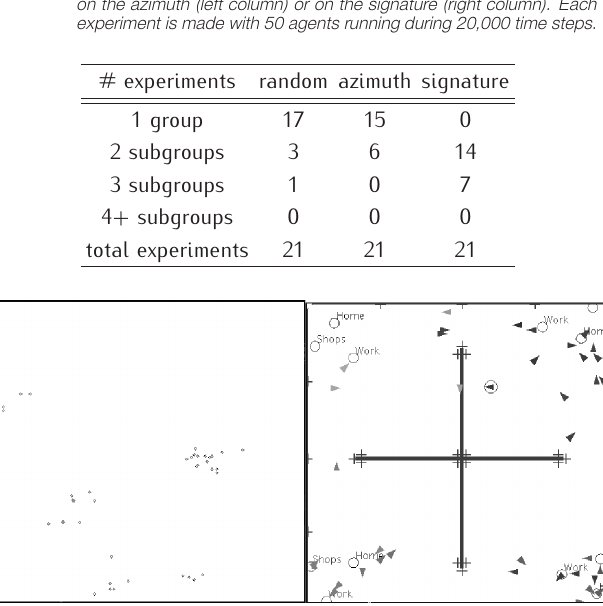
Figure 11. An example showing that imitation on signatures can lead to situa- tions where the number of subgroups (5, left picture) is greater than the number of villages (4, right